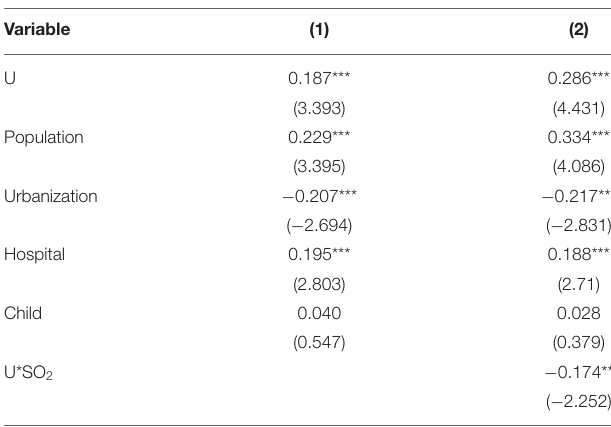
TABLE 4 | Regression